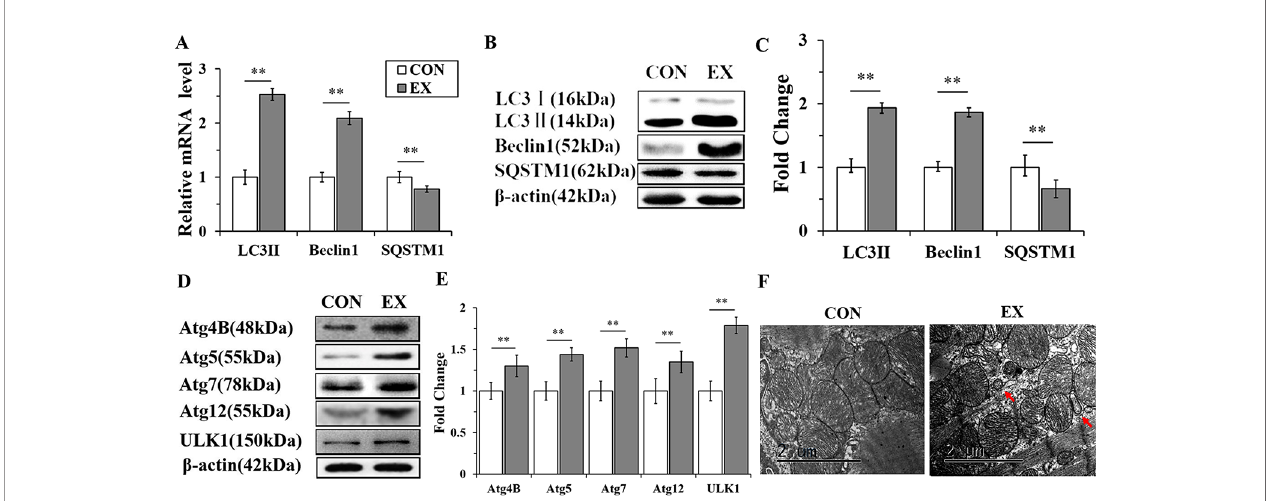
FIGURE 2 | Autophagy is markedly enhanced in swimming-induced physiological cardiac hypertrophy in rats. (A) , Real-time quantitative (RT-q)PCR analysis for mRNA expression of LC3B, Beclin 1, and SQSTM1 (relative to b -actin). (B , C) , Western blot analysis for LC3B, Beclin 1, and SQSTM1 (relative to b -actin). (D , E) , Western blot analysis of samples from CON and EX group detected Atg4B, Atg5, Atg7, Atg12 and ULK1. (F) , Representative transmission electron microscopic images of autophagosomes. Autophagosomes (red arrows). Images were obtained at a magni fi cation ×13,000. Scale bar, 2 m m. ** P < 0.01, EX group (n=16) vs . CON group (n=16). Data are presented as means ± SD. Statistical signi fi cance was evaluated with the two-tailed Student's t